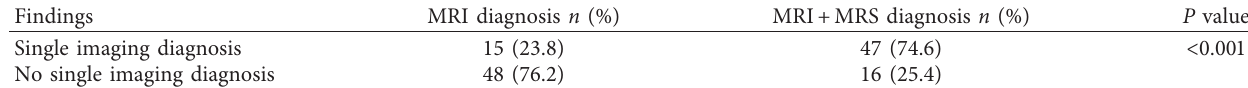
Table 2: Overall diagnostic performance between MRI diagnosis and MRI+MRS diagnosis. Findings